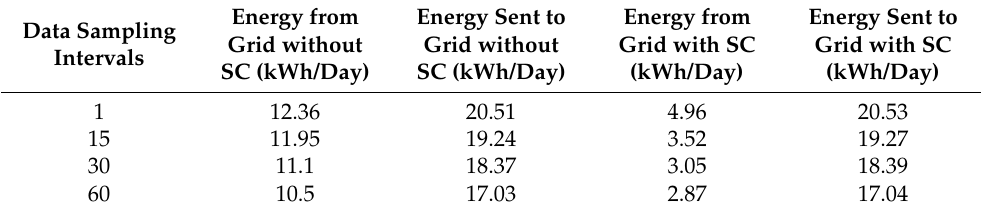
Table 2. Relative error of data measurements, self-consumption considering SC.